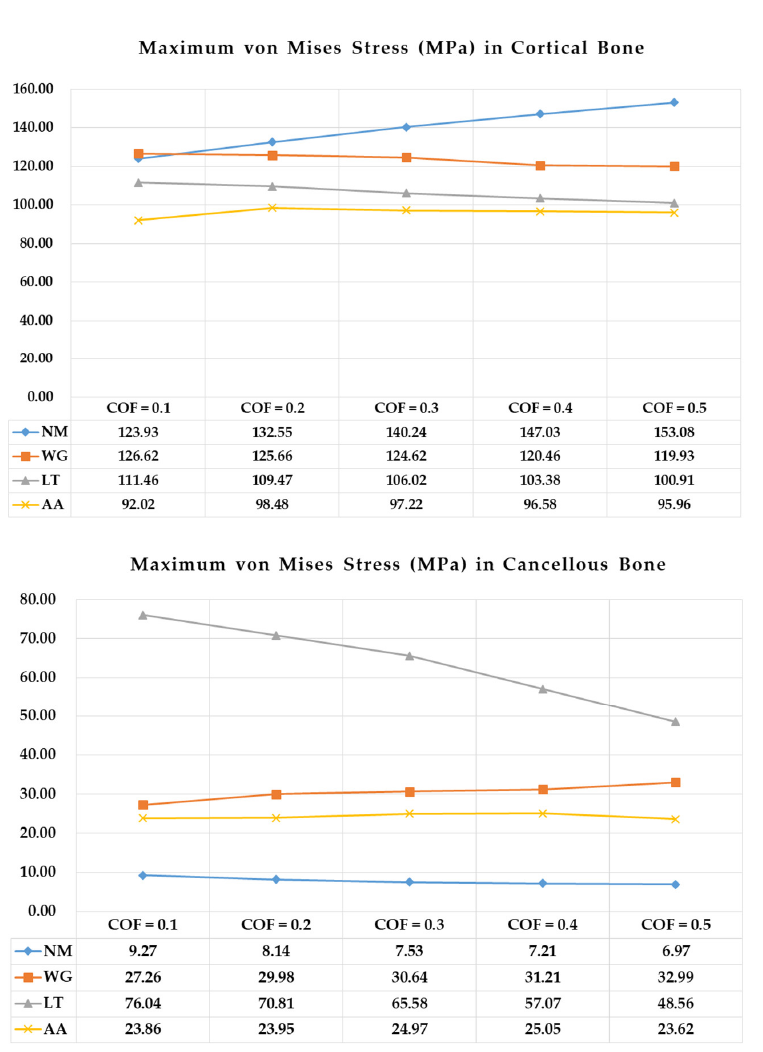
Figure 8. Maximum von Mises stress (MPa) values on cortical and cancellous bones in each experimental group according to the frictional coefficient (COF) values.